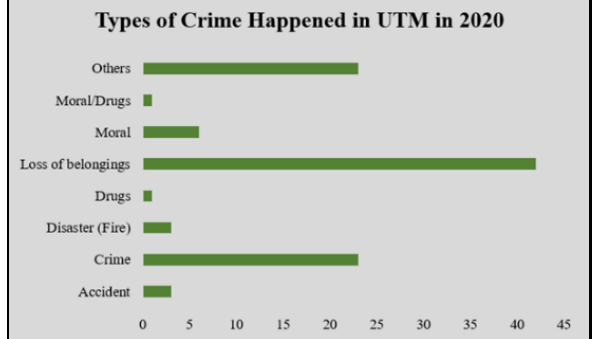
Figure 1. Graph of Types of Crime Happened in UTM in 2020.